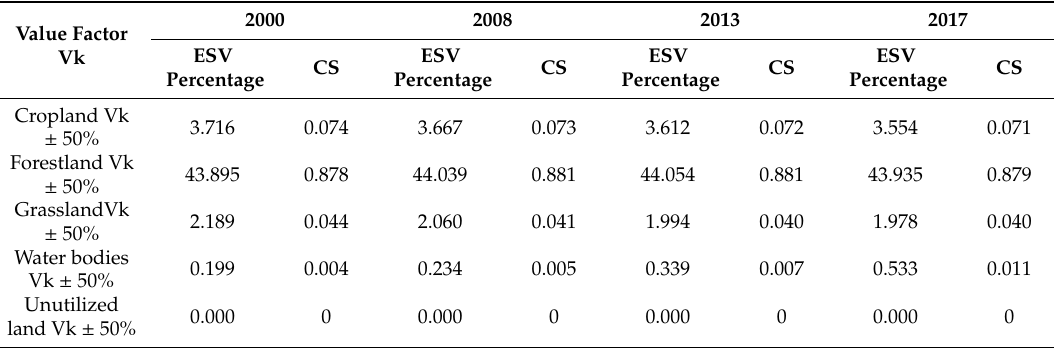
Table 3. Sensitivity